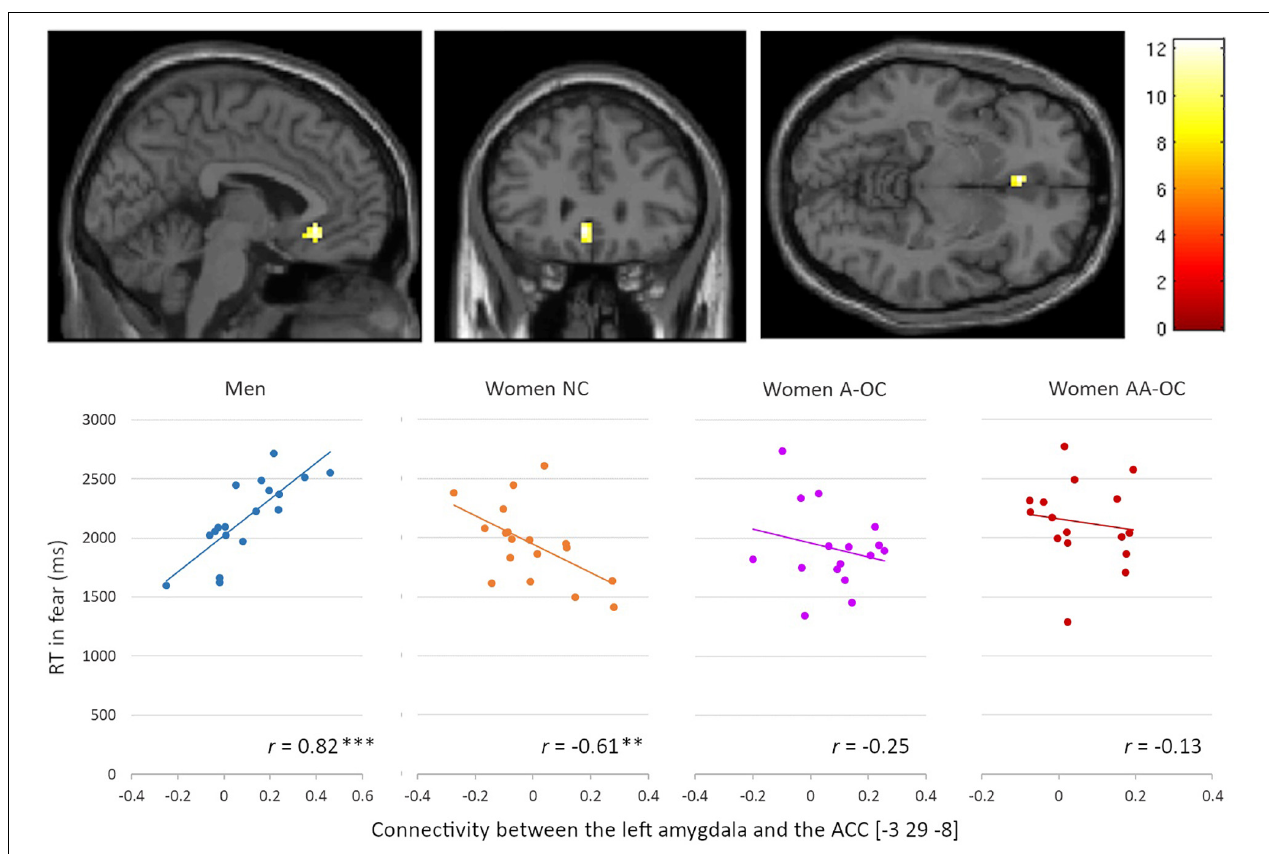
FIGURE 5 | Relationship between the left amygdala-anterior cingulate cortex connectivity and reaction time (RT) for fearful faces by group. Connectivity strength and RT were found to be positively correlated for men, whereas they were negatively correlated for naturally cycling women. ** p < 0.01, *** p <